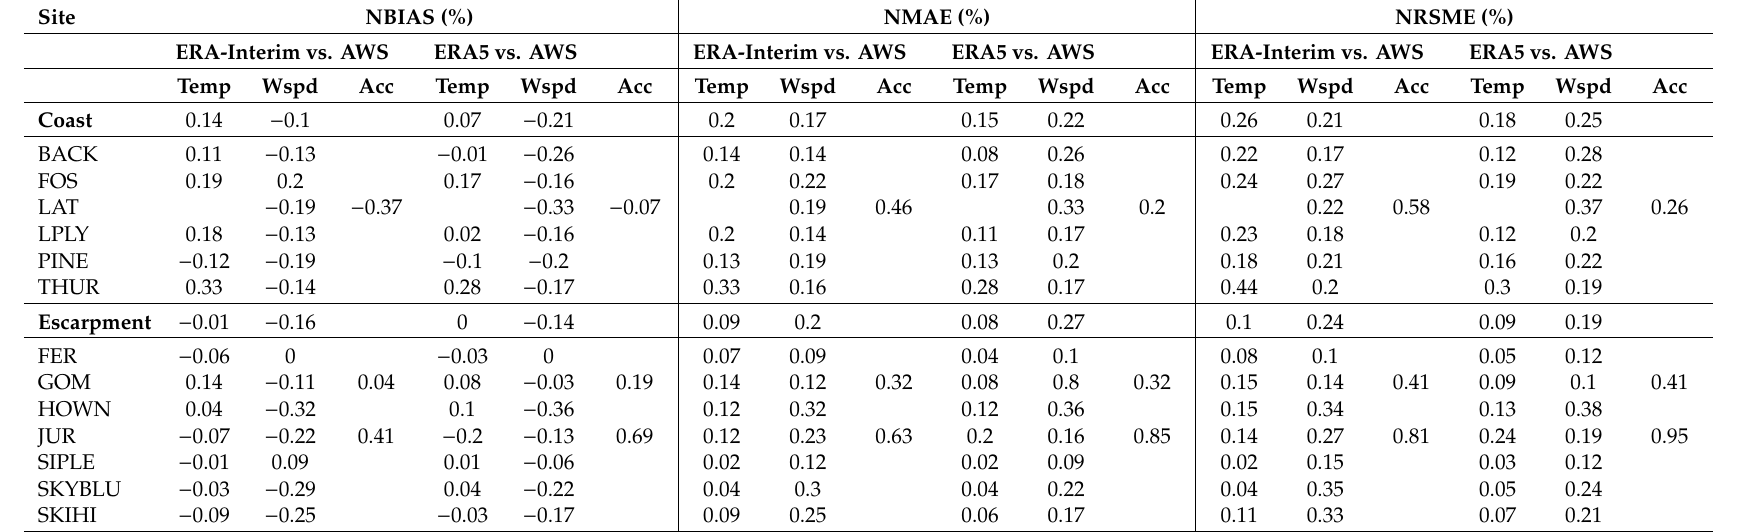
Table 5. Performance indicators obtained using AWS datasets and climate reanalyses. Temp: Temperature. Wspd: Wind speed. Acc: